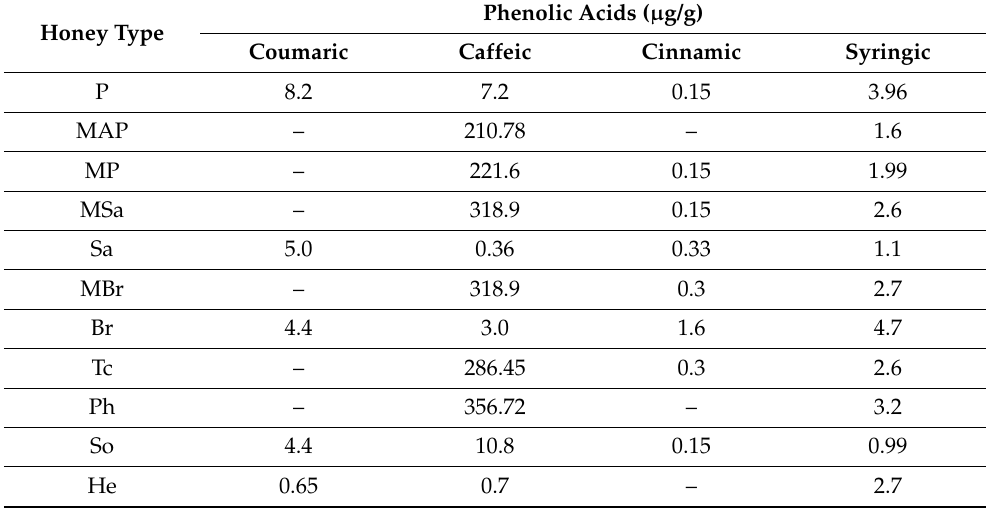
Table 4. Selected phenolic acid content; (-)–not detected. Honey